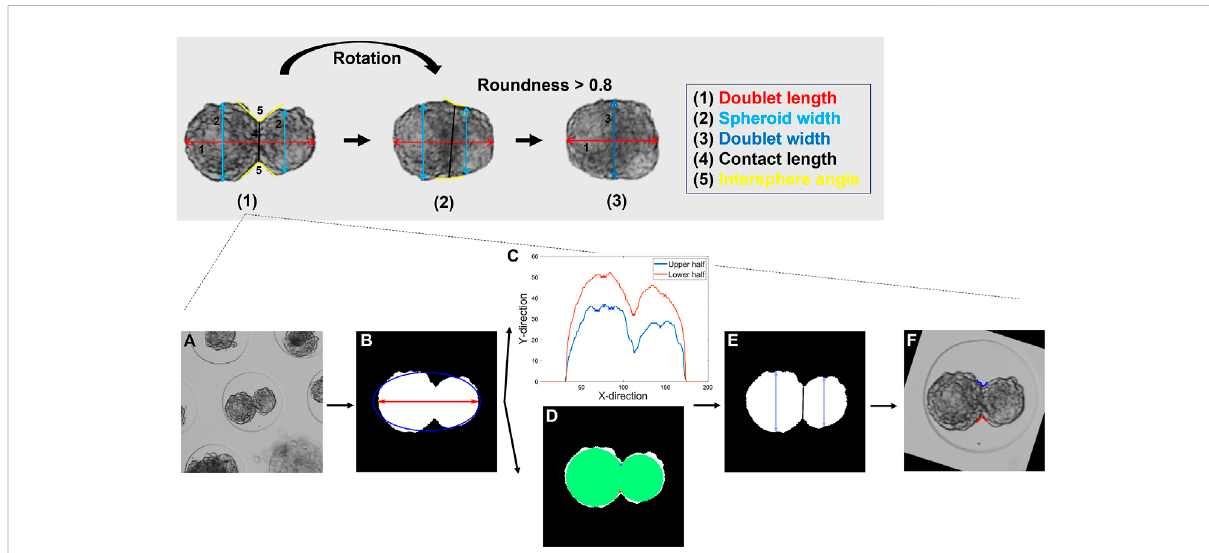
FIGURE 3 Description of the feature extraction procedure. Top panel: Visualization of the three different stages of the feature extraction with (1) the initialization for frame 1 and the subsequent feature extraction (2) before and (3) after a doublet roundness of 0.8 was reached. Bottom panel: Detailed representation of stage (1). (A) Raw image. (B) Segmented mask. The doublet area, length, and roundness were extracted. (C) Pro fi le of the upperandlowerhalfofthedoubletwiththedetectedminima. (D) Alternativemethodforthedetectionofthespheroid ’ sinterfacebasedontwo maximally inscribed circles. (E) A cost function was de fi ned to select the appropriate pro fi le points. The spheroids were separated, and the contact length and both spheroid widths computed. (F) Upper and lower intersphere angles were extracted. (2) For subsequent frames, the same features as in (1) were extracted, and the rotation of the doublet with respect to the previous frame was determined. (3) As previously described, the mask was alignedwith thehorizontalaxis.The doubletarea, length, andwidthwereextracted.Moredetailsonthefeaturesandthefeatureextractionarelisted in the supplementary information (details on Panel 3 or Supplementary Table